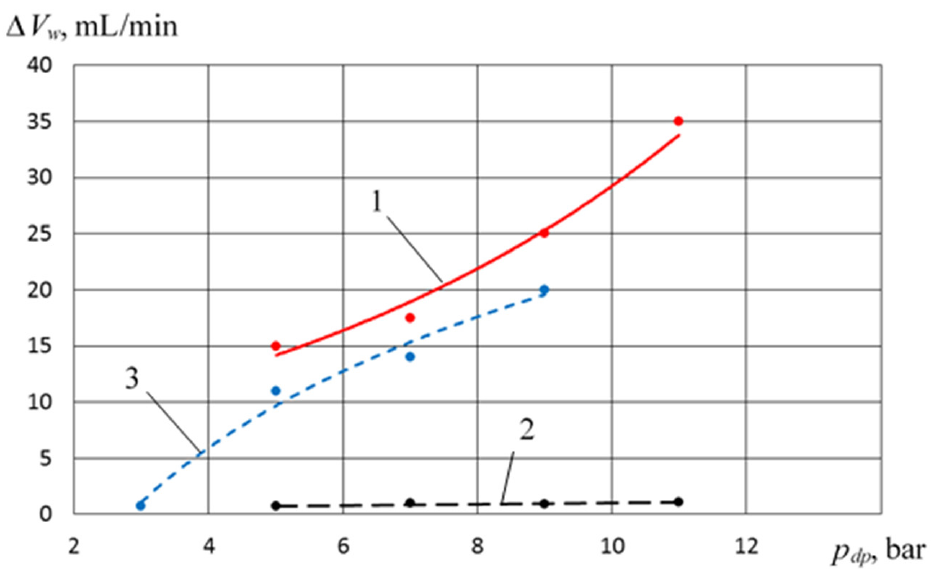
Figure 25. Dependence ∆ V w on the discharge pressure of the pump section (1—PHPM with step-type gap seals; 2—PHPM with smooth gap seals; 3—Crosshead-free